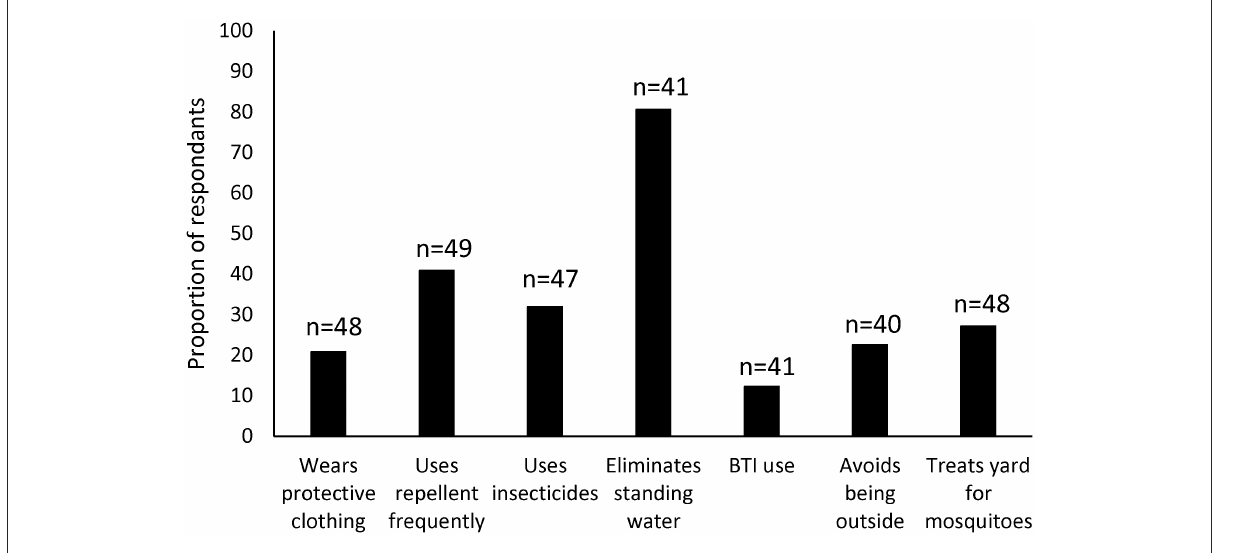
FIGURE4 Proportion of respondents self-reporting protective